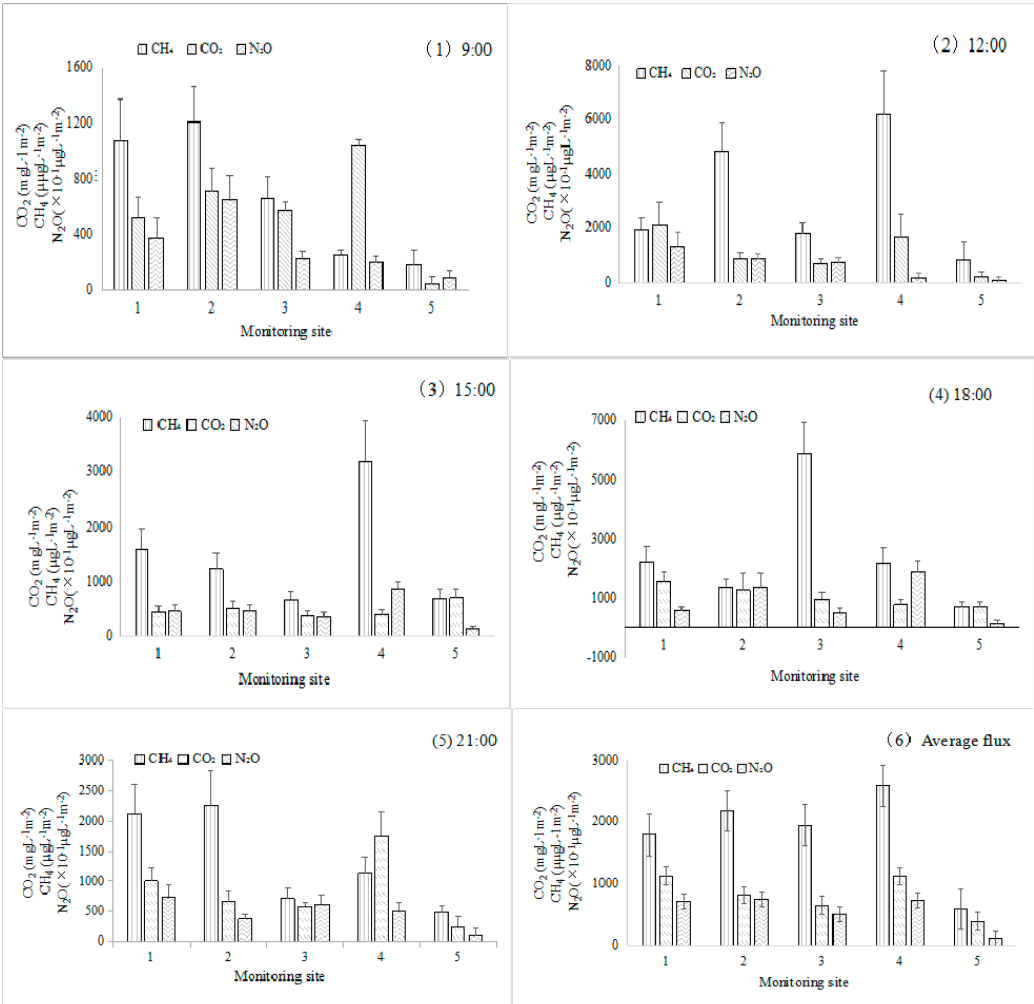
Figure 2. Average greenhouse gas (GHG) flux in the water–air interface of the Huoshaogou River.